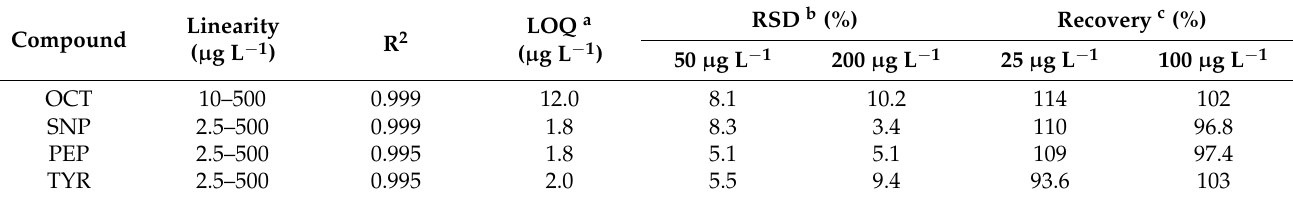
Table 3. Analytical characteristics of the DLLME and UHPLC-Q-TOF-MS